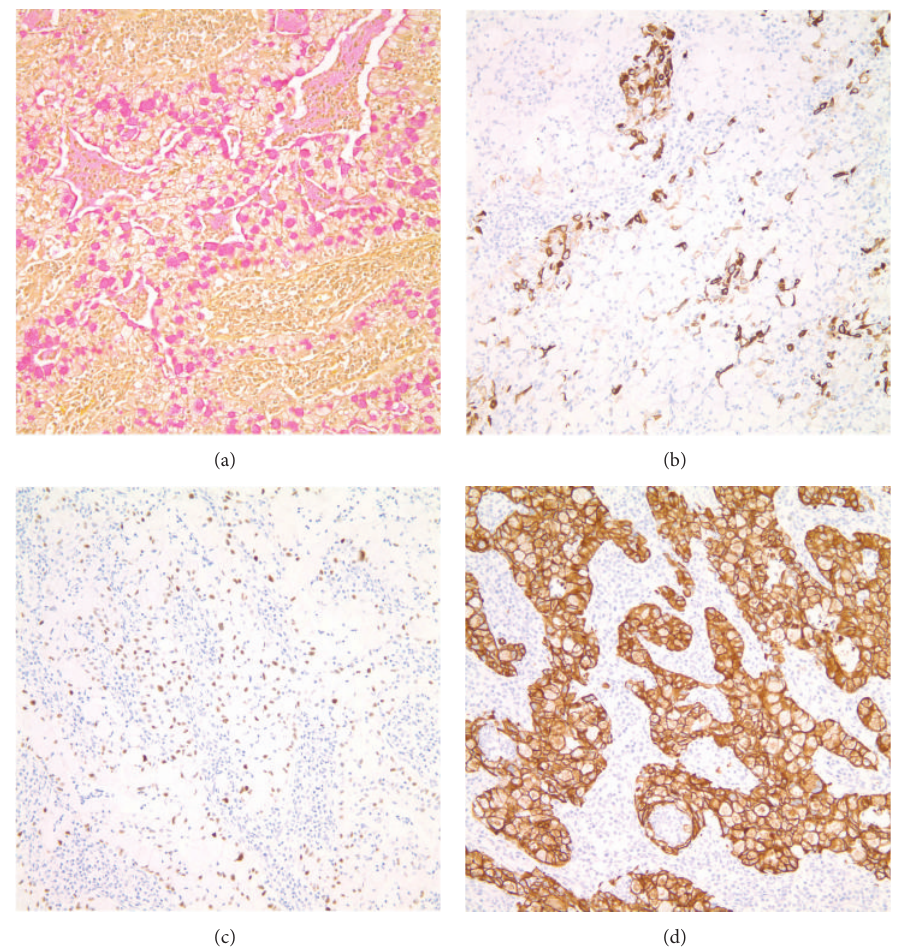
Figure 3: Immunohistochemistry showing staining with mucicarmine (a), CK 5, and 6 (b), p63 (c) and CK 7 (d).